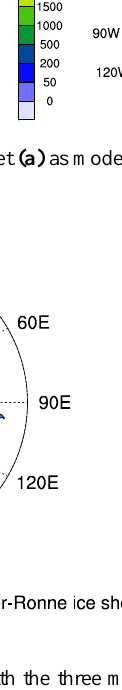
Figure 6. The Antarctic ice sheet in blue, with the three major ice shelves indicated in different colours.